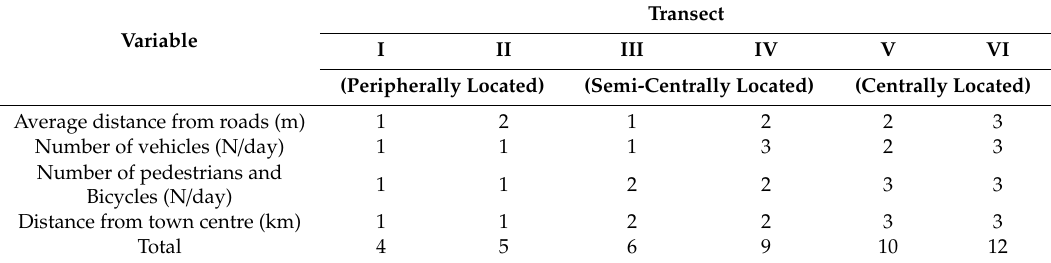
Table 2. The atheroprogression level (N of points assigned) for the six transects, located along the Gwda River banks, with the general location in relation to the central urban area (in brackets).